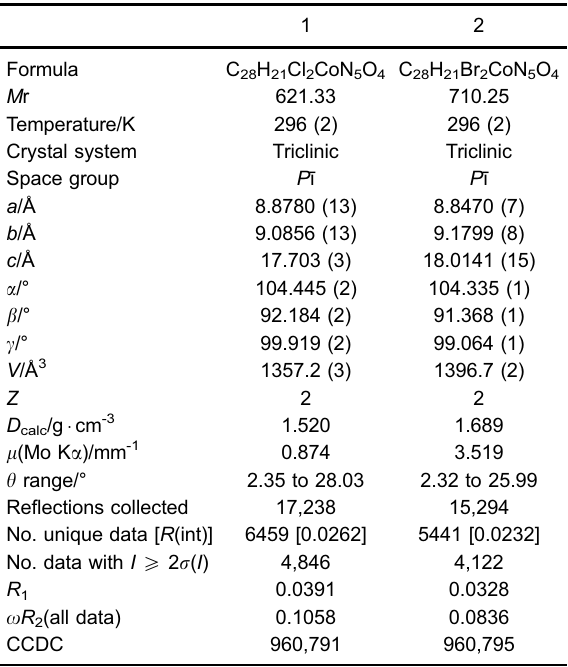
Table 1. Crystal data and structure re fi nement for Py 3 CoL 1 (1) and Py 3 CoL 2